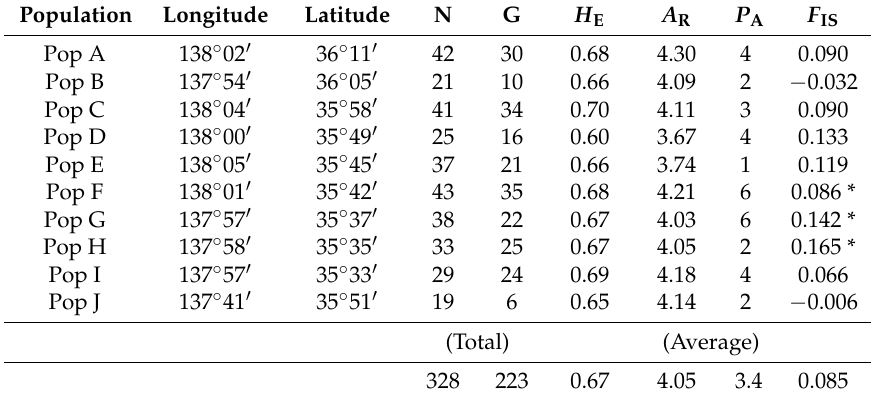
Table 1. Baseline parameters of the 10 populations of matsutake mushrooms in Nagano prefecture, Japan, including sample sites, baseline data, and genetic diversity based on 15 nuclear microsatellite markers. Population Longitude